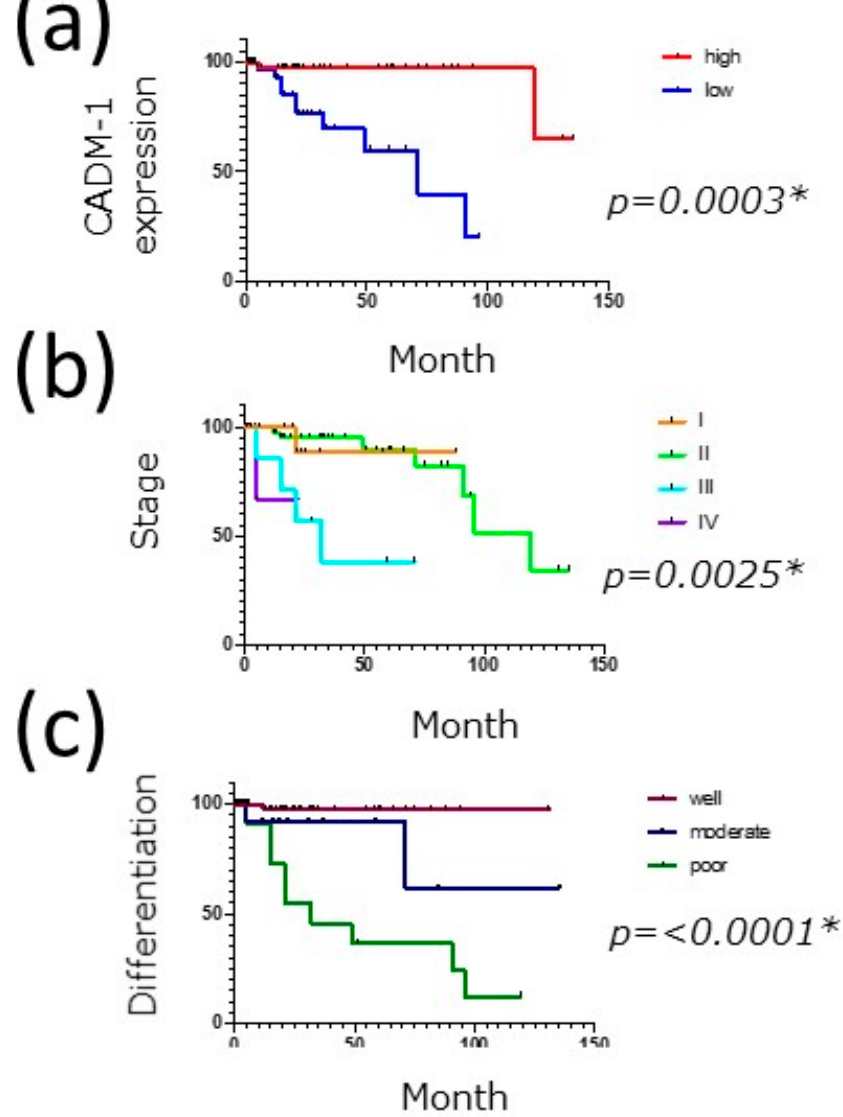
Figure 2. OS in patients with cSCC. Kaplan–Meier curves were generated by OS with differences in the ( a ) CADM1 expression, ( b ) clinical stages, and ( c ) differentiation. The p -value was evaluated by the log-rank test. * indicates a statistical significant difference.